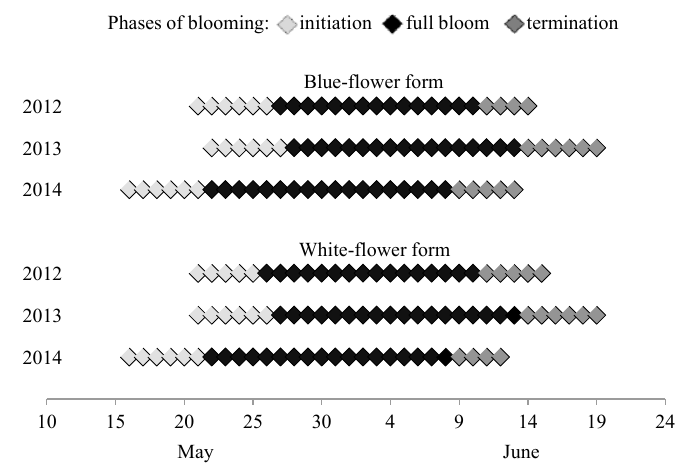
Fig. 1 Blooming phenology of Polemonium caeruleum in the period of 2012–2014, Lublin, SE Poland.